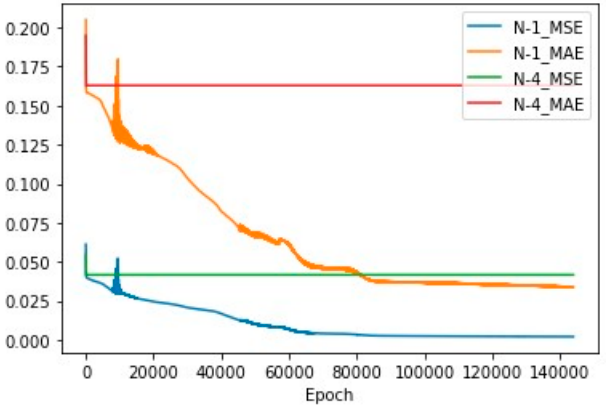
Figure 8. MSE and MAE during networks’ training.